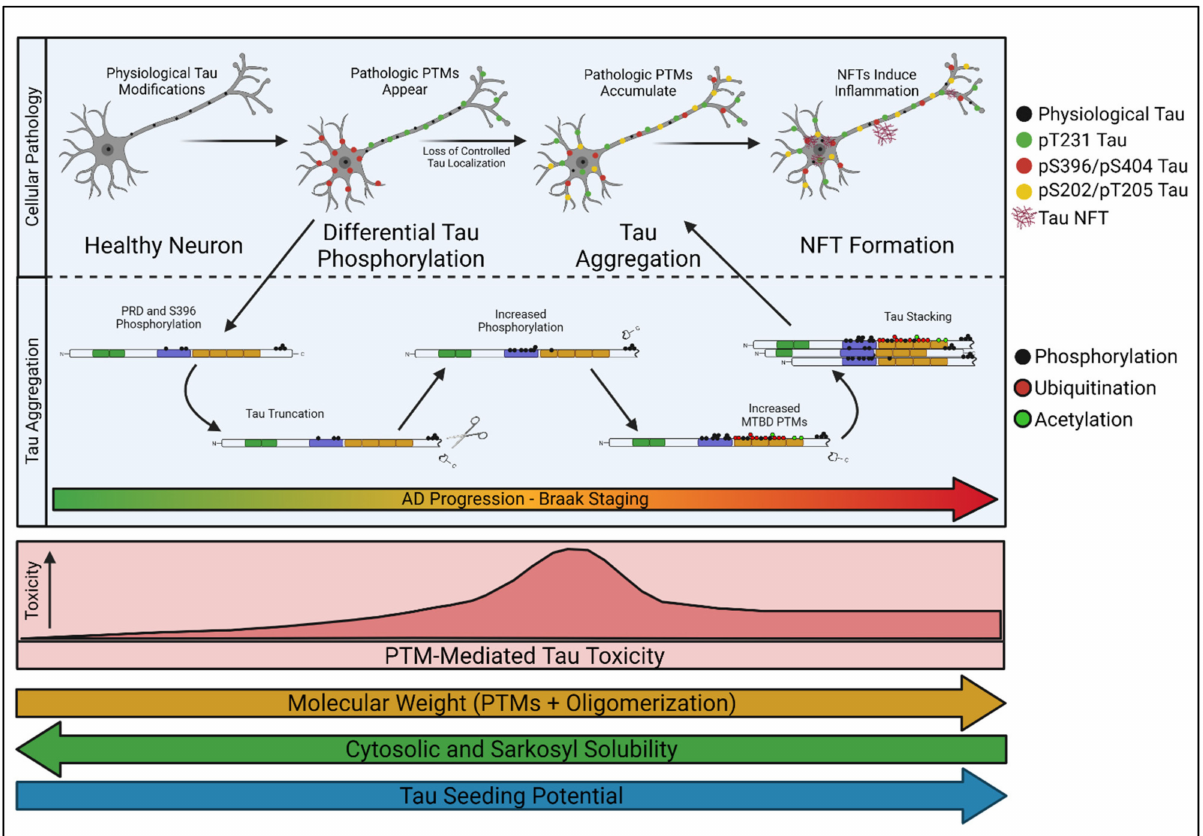
Figure 3. Model for tau transformation. In normal conditions, tau is physiologically modified and is non-toxic. Early in pathology, tau is differentially phosphorylated within the axon and soma of the neuron, leading to defective control over tau localization. These early phosphorylation epitopes, like pT231 and pS396, are associated with further tau modifications and may facilitate subsequent C-terminal cleavage and oligomerization of tau [24]. As disease progresses, tau’s molecular weight and seeding potential generally increase as solubility decreases, but tau’s toxicity is likely greatest when tau species remain